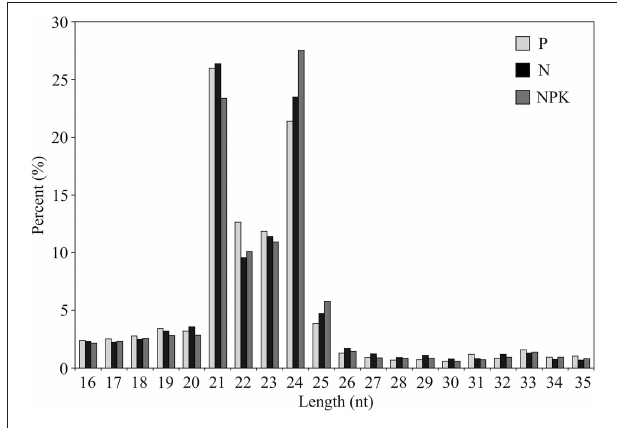
FIGURE 1 | Length distribution of sRNAs.